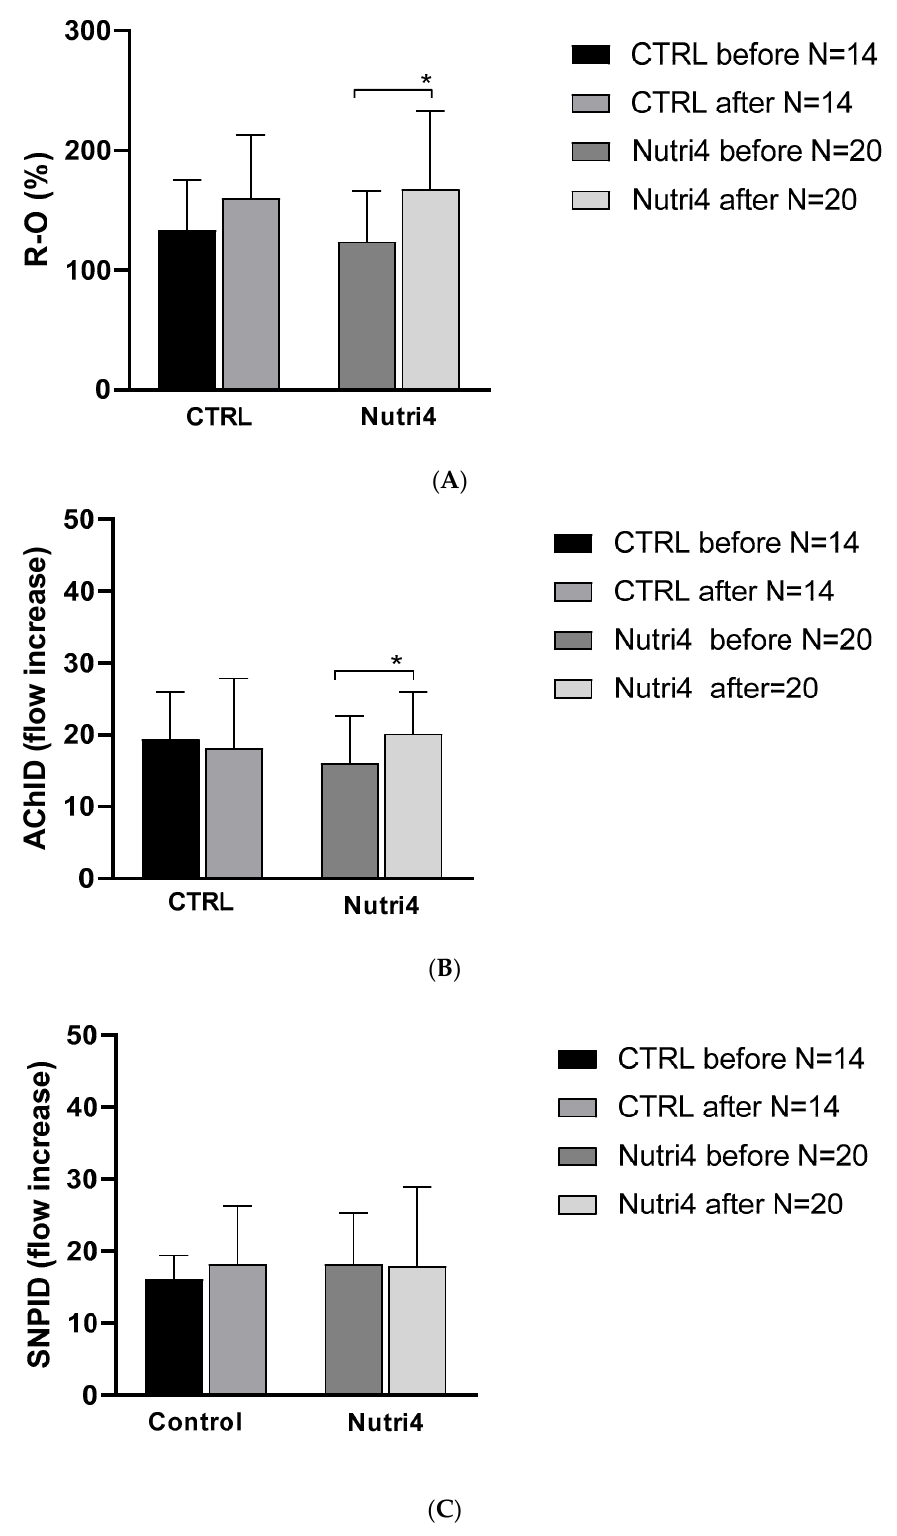
Figure 2. Panel ( A ). Post-occlusive reactive hyperemia (PORH) before and after the dietary protocol. Results are shown as mean ± standard deviation (SD); * p < 0.05 before or after within the group (CTRL or Nutri4). Panel ( B ). Forearm skin microcirculation by iontophoresis—AChID before and after the dietary protocol. Results are shown as mean ± standard deviation (SD); * p < 0.05 before or after within the group (CTRL or Nutri4). Panel ( C ). Forearm skin microcirculation by iontophoresis sodium nitroprusside-induced dilation—SNPID before and after the dietary protocol. PORH, enhanced after Nutri4 eggs consumption was signi fi cantly decreased after administration of 100 mg indomethacin in the Nutri4 group, while it remained unchanged CTRL group after the dietary protocol and after the intake of 100 indomethacin (Figure 3B).